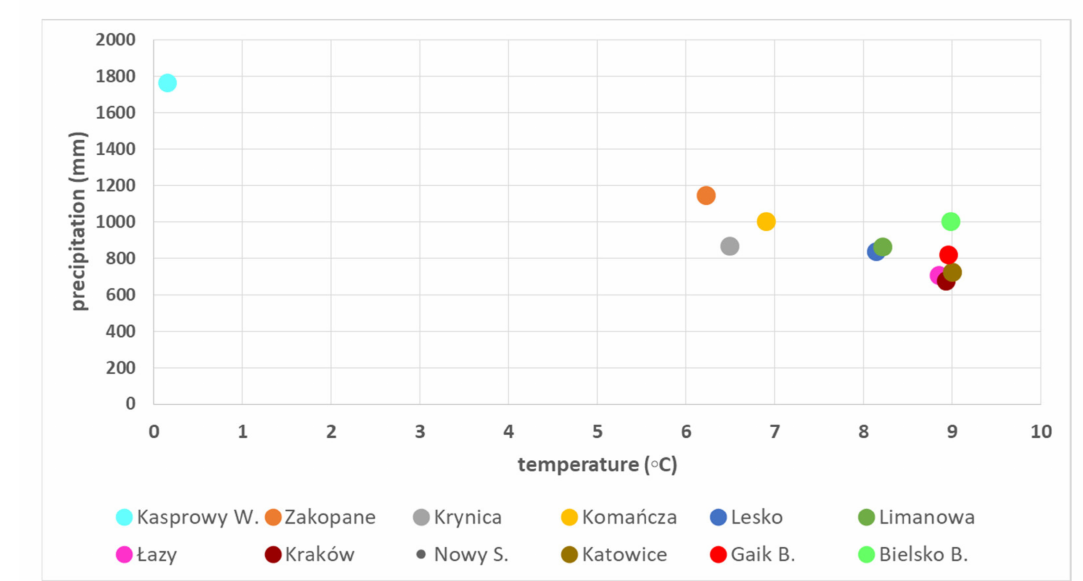
Figure 4. Comparison of mean annual air temperature and precipitation totals for the period 1991–2020 for the stations studied. The value for Nowy S ˛acz is not visible in the figure as it is almost identical to the value for Katowice and the symbols overlap each